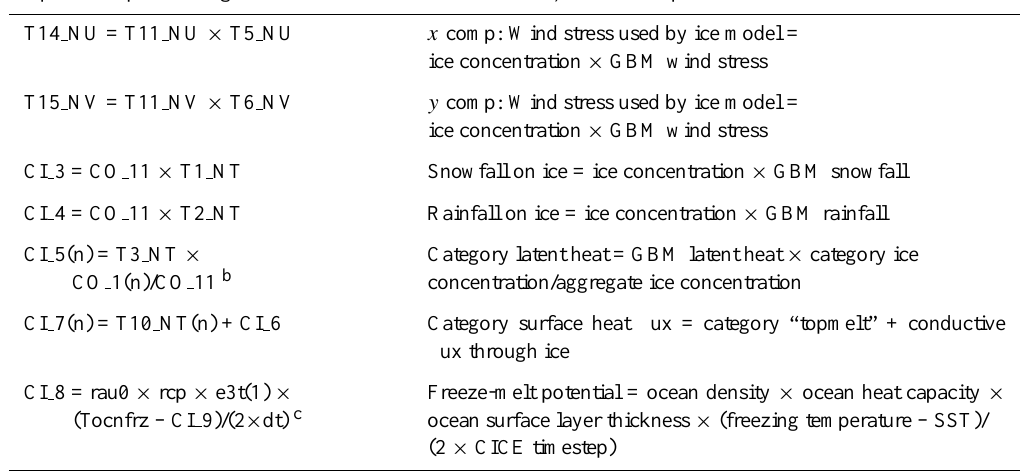
Table 1d. Details of partitioning the atmospheric stresses and fluxes for the ice model in Fig. 4. These manipulations are in the NEMO subroutine CICE SBC IN . “n” is the ice thickness category index. Operation: partitioning of stresses and fluxes for ice model; freeze-melt potential calculation a